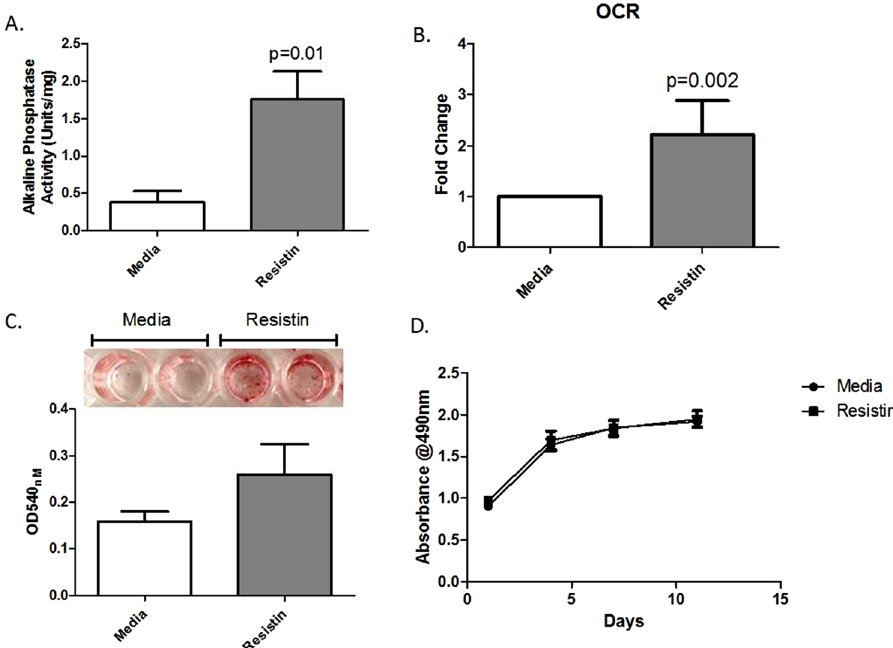
Figure 4. The functional impact of resistin on the metabolic activity and bone nodule formation of human primary OA osteoblasts. ( A ) Alkaline phosphatase activity of human primary OA osteoblasts from the femoral subchondral bone following 2wk stimulation with either resistin (500 ng/ml) or media control. Bars represent mean values ± SEM (n = 4). ( B ) The fold change in the oxygen consumption rate (OCR) following 24 h stimulation of primary human OA osteoblasts with resistin (500 ng/ml), compared to non-stimulated osteoblasts. OCR values (pmol/min) were normalized to total protein following cell lysis prior to fold change calculation. Bars represent mean values ± SEM (n = 10). ( C ) Representative image of alizarin red stained mineralised bone nodules following 4 wk stimulation of primary hip OA osteoblasts with either resistin (500 ng/ml) or media control. Alizarin red staining was quantified using Image J software. Bars represent mean values ± SEM (n = 4). ( D ) Time-course of human primary hip OA osteoblast cell proliferation following stimulation with and without resistin (n =